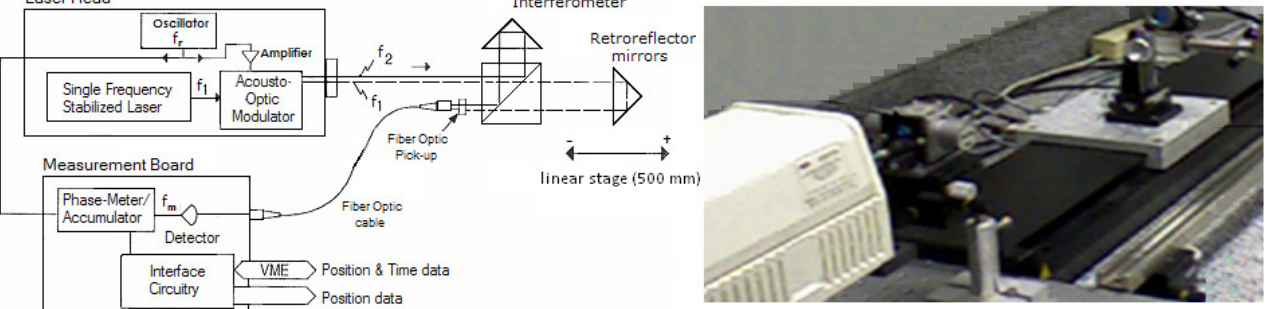
Fig. 1. Schematic diagram and photo of the proposed experimental setup.